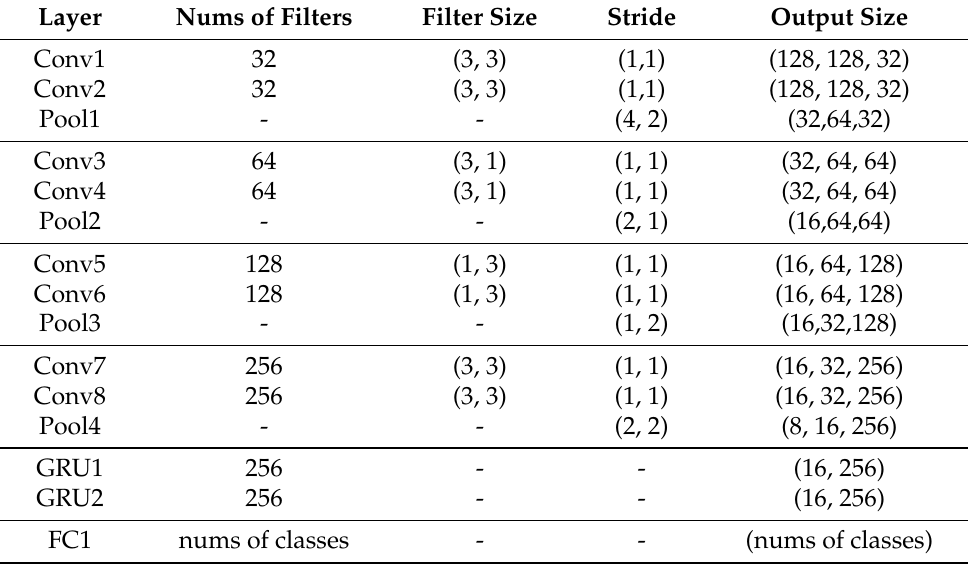
Table 2. Architecture of the proposed convolutional recurrent neural network (CRNN).